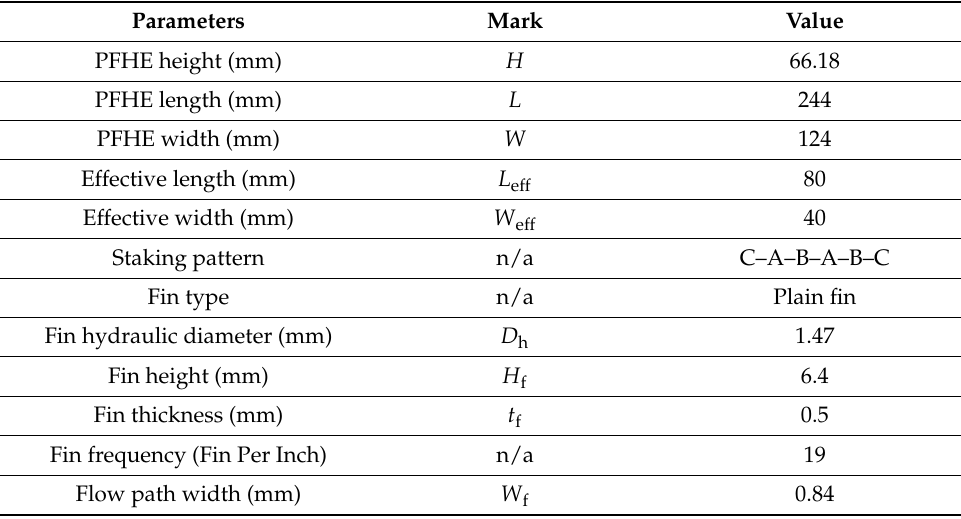
Figure 3. Schematic diagram of internal geometric structure of PFHE. ( a ) 2-stream PFHE. ( b ) Multi-stream PFHE. Table 1. Summary of geometric dimensions of the PFHE.